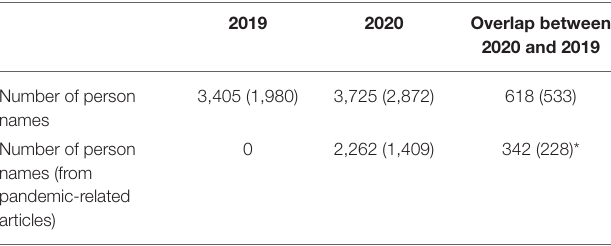
TABLE 3 | Unique person names from forward-looking statements. In brackets, we give the number of persons that can be found in Dimensions (* compared with total of 2019).